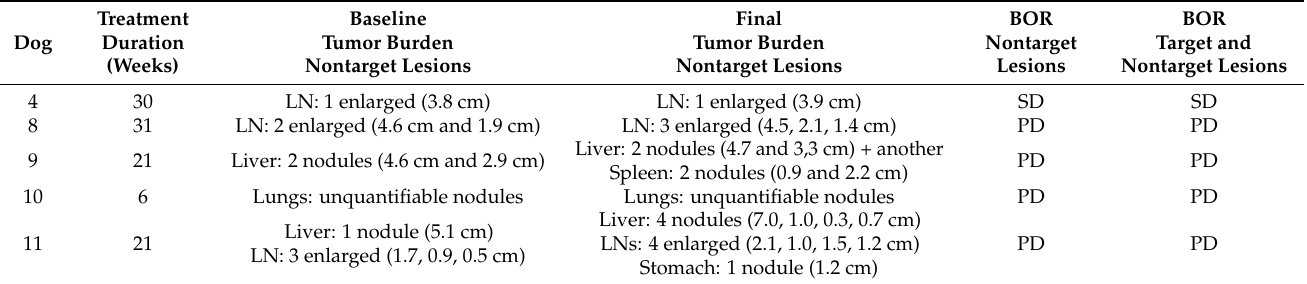
Table 3. Response to treatment in nontarget lesions, not injected with